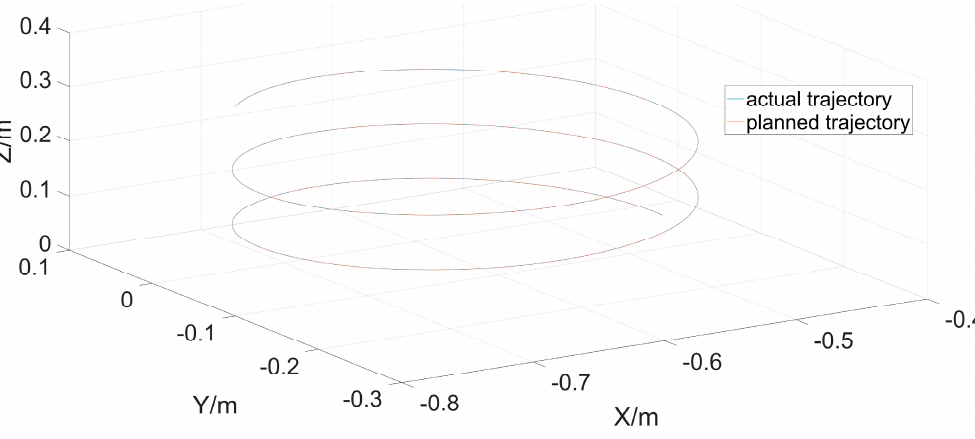
Figure 19. The joint trajectory after the inverse kinematics solution. In the fourth experiment, the Beckhoff controller, which is commonly used in the industry, was used and the general algorithm was implemented in the controller. The robot controller sends motion commands to the drive at a certain period. This requires the controller to complete the kinematic inverse solution within a specified amount of time to ensure the continuity. A shorter period results in a higher real-time performance. The period used in this article was 2 ms. The 2 ms cycle is sufficient to meet the general accuracy requirements. For example, in Ref. [5] the medical robot can accept a closed loop period of 20 ms. In other words, the proposed algorithm in this paper could achieve a